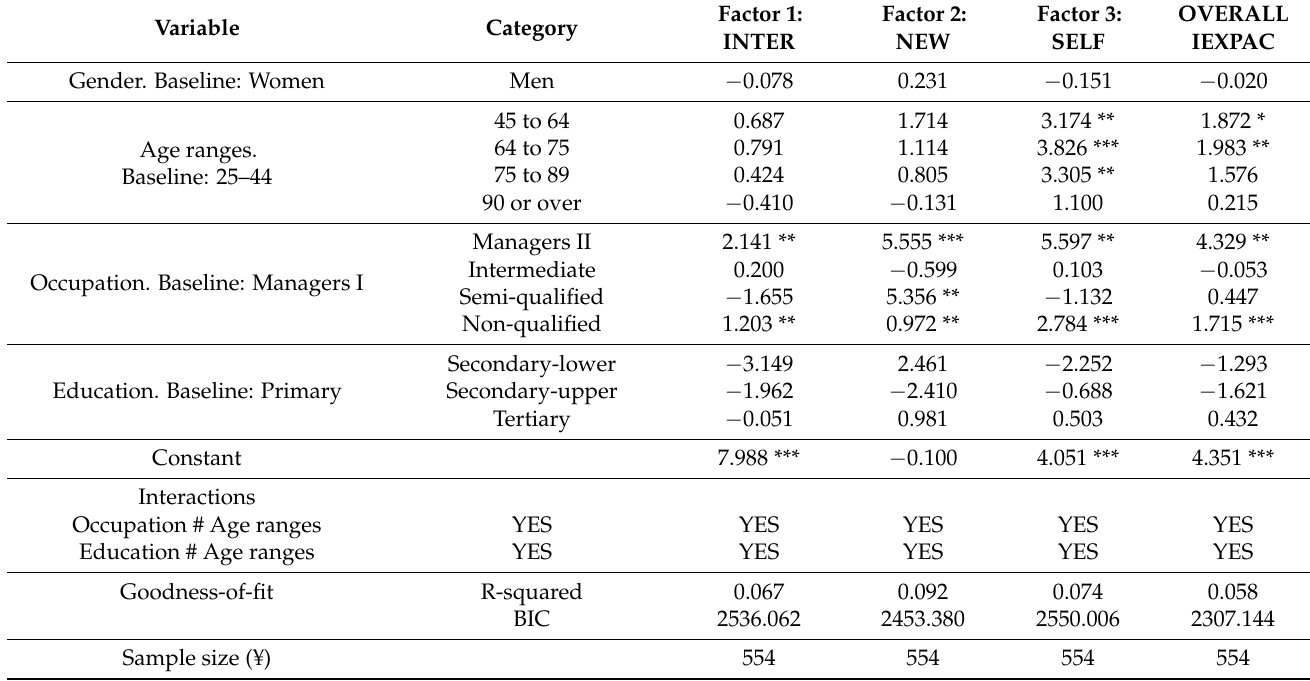
Table 3. Model 1—WLS results. Differences in healthcare experience among patients with self-declared diabetes. The effect of sociodemographic and economic